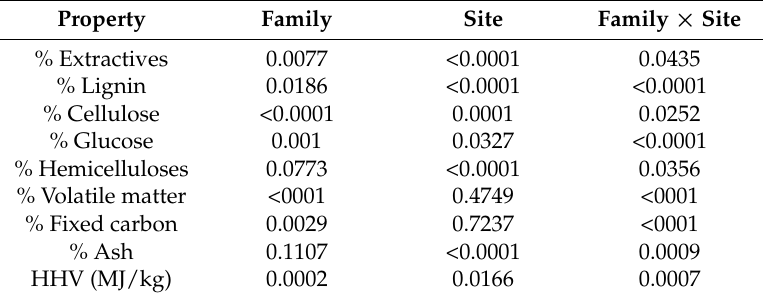
Table 4. ANOVA p -values per treatment for the chemical, proximate and energy contents.